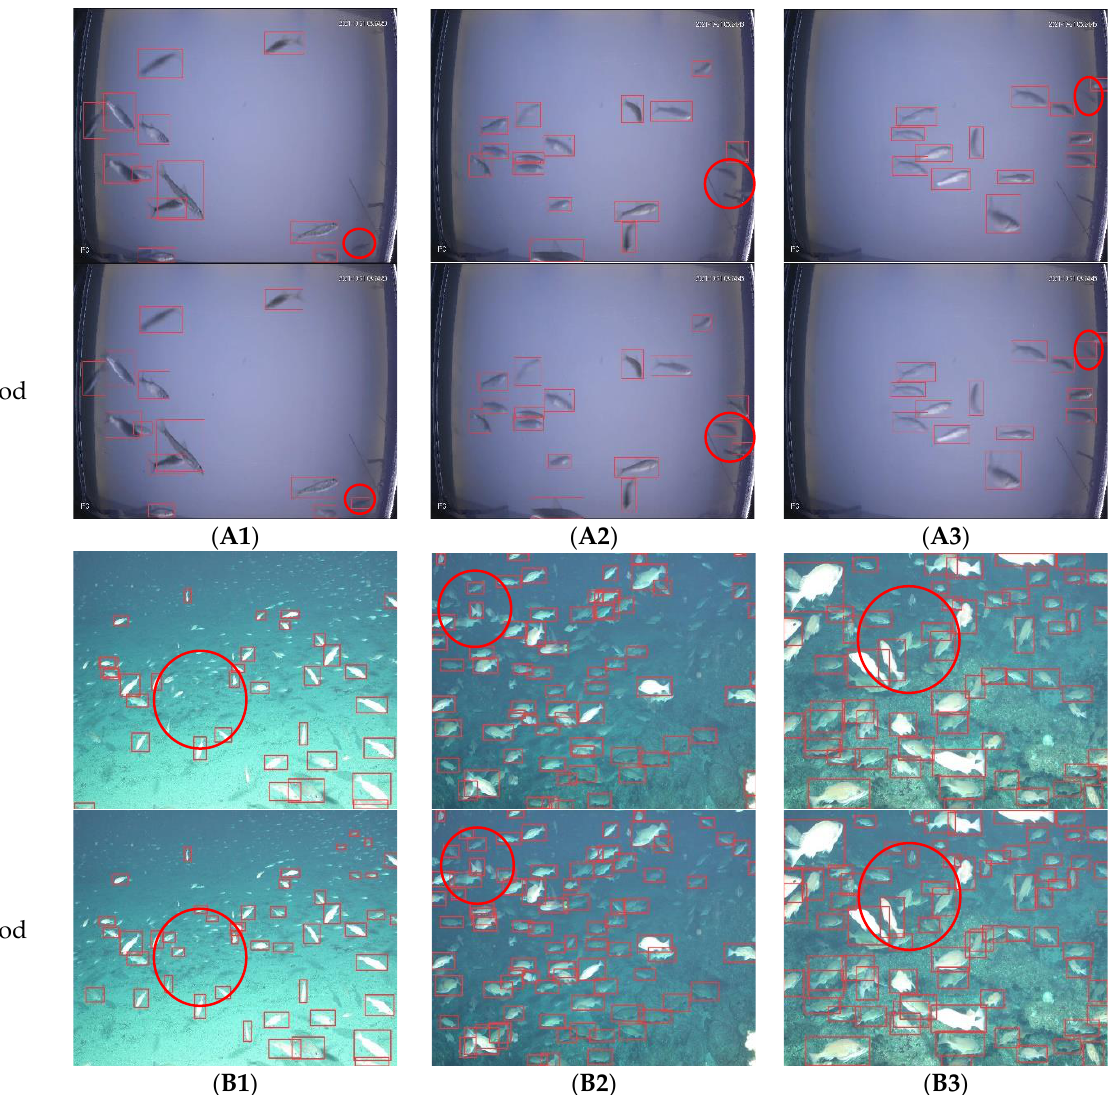
Figure 4. This is a figure showing the prediction results of the model: ( A1 ) detection result of an occluded target in a power station image; ( A2 ) detection result of a small target in a power station image; ( A3 ) detection result of a fuzzy target in a power station image; ( B1 ) small target fish image detection results; ( B2 ) densely spaced fish and small target detection results; and ( B3 ) fish and small target detection results under exposure.